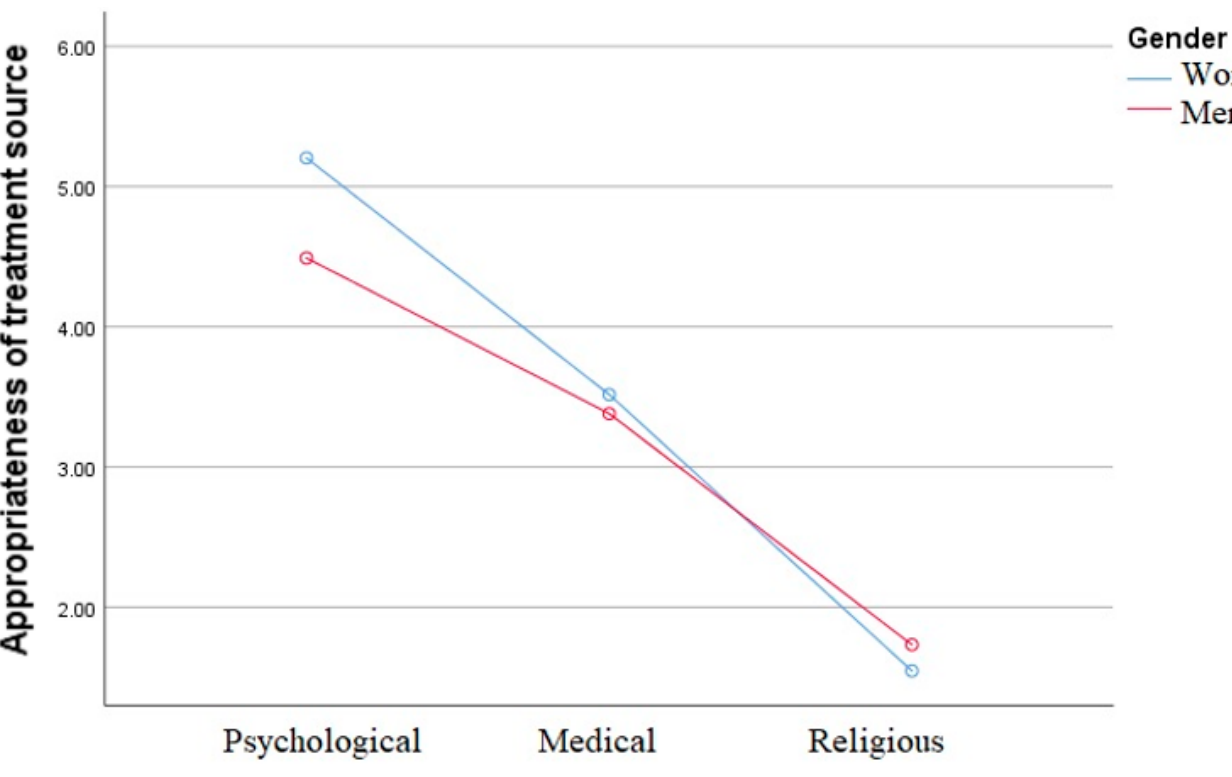
Figure 1. Interaction between gender and appropriateness of treatment sources. Note: Main effect of treatment source (F (2,220) = 392.49, p < 0.001), interaction between gender and treatment source (F (2,220) = 8.07, p < 0.01).